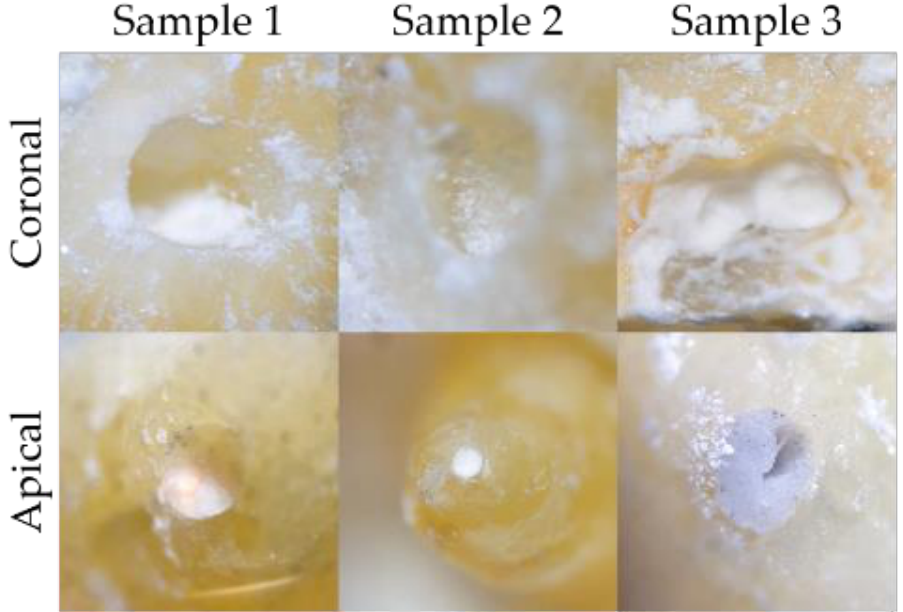
Figure 10. Apical and coronal microscopic views of root canals from extracted human teeth following BDD-mediated obturation.